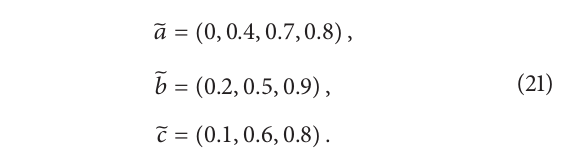
Figure 7: It is shown that ̃𝑎 ≺ ̃𝑐